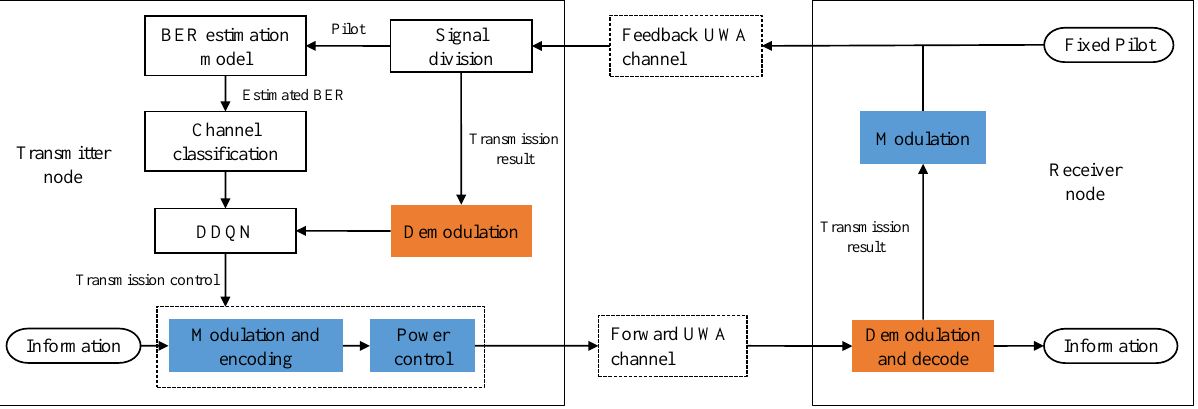
Figure 3. The structure diagram of the proposed AMC